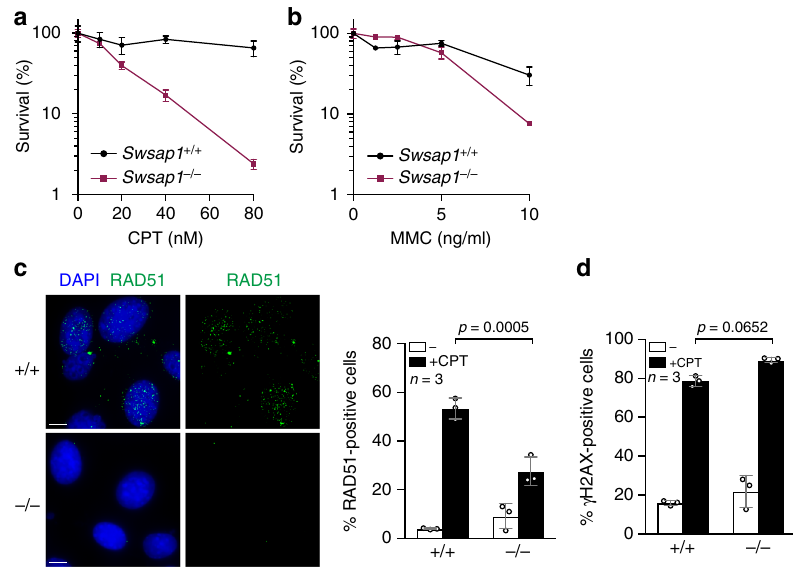
Fig. 6 RAD51 assembly defects during mitosis in Swsap1 knockout (KO) mice. a , b Clonogenic survival assays of immortalized Swsap1 + / + and SWSAP1 − / − cells exposed to different concentrations of camptothecin (CPT) and mitomycin C (MMC). A number of colonies with and without treatment of the DNA- damaging reagents were counted after 10 – 14 days culture. Data are mean ± s.e.m. Statistics and reproducibility, see accompanying Source data. c RAD51- positive cells in Swsap1 + / + and Swsap1 − / − cells after CPT treatment. Swsap1 + / + and Swsap1 − / − mouse embryonic fi broblast cells were treated with 100 nM C PT for 22 h. Cells were fi xed and stained for RAD51 (green). Left, Representative images of RAD51-immuno fl uorescence staining. Bar 10 µ m. Right, Quanti fi cation RAD51-positive cells in the indicated cell lines. More than 200 cells were counted. Data are mean ± s.d. Statistical signi fi cance was measured by Mann – Whitney ’ s U -test. Statistics and reproducibility; see accompanying Source data. d Quanti fi cation of γ H2AX-positive cells in Swsap1 + / + and Swsap1 − / − cells after CPT treatment. CPT-treated cells were stained for γ H2AX. Data are mean ± s.d. Statistical signi fi cance was measured